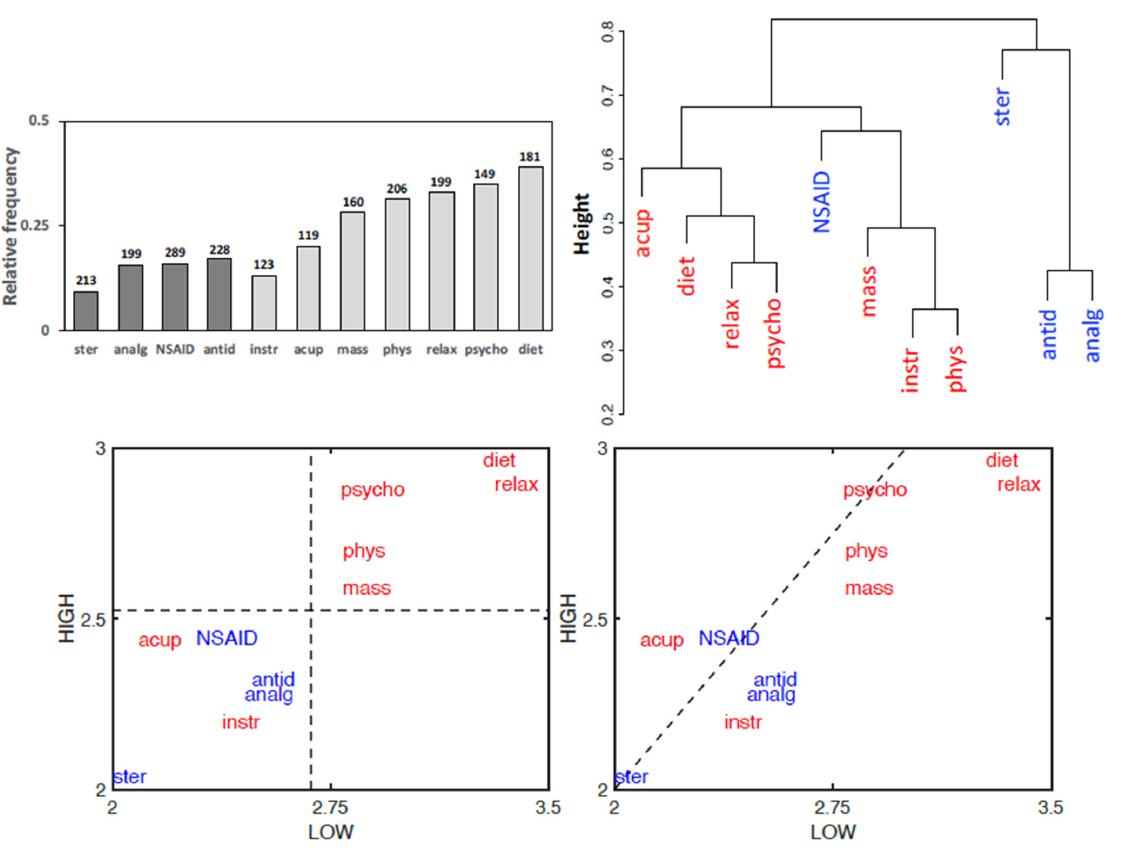
Figure 7. Patient’s classification of the therapy efficacies. ( Top left ) Cumulated relative frequencies of the two highest ratings out of five (null; low; average; good; excellent). Numbers above bars indicate total valid responses. Darker bars: pharmacological treatments; lighter bars: non ‐ pharmacological treatments. ( Top right ) Dendrogram generated using an average linkage agglomerative algorithm based on pairwise correlations between the effectiveness of the different treatments (Pharmacological treatments = blue; non ‐ pharmacological treatments = red; data as in Figure 4). ( Bottom ) Bidimensional plots of the pharmacological (blue) and non ‐ pharmacological (red) treatment effectiveness. The coordinates of each treatment are the average values of effectiveness reported by subjects rating as “low” (horizontal axis) or “high” (vertical axis) in the PD ‐ Q test. In the left panel, the perpendicular dotted lines, intersecting axes at global mean values, show that most non ‐ pharmacological treatments are generally more effective than pharmacological ones. In the right panel, the axes bisector (dotted line) shows that most treatments are judged more effective by “low” subjects. Statistical comparisons by the Wilcoxon test show that non ‐ pharmacological treatments are judged more effective than pharmacological ones by the whole population of patients (n = 344, p = 2.03 × 10 − 11 ), as well as by analyzing separately “high” subjects (n = 233, p = 5 × 10 − 8 ) or “low” subjects (n = 38, p = 0.018). Mind-body therapies have been reported as the most effective in absolute. Non-pharmacological treatments: acup = acupuncture; diet = diet therapy; mass = massages; instr = non-invasive instru- mental treatments; phys = physical therapy; psycho = psychotherapy; relax = relaxation therapy. Pharmacological treatments: analg = analgesics; antid = antidepressants; NSAID = non-steroidal anti-inflammatory drugs; ster =